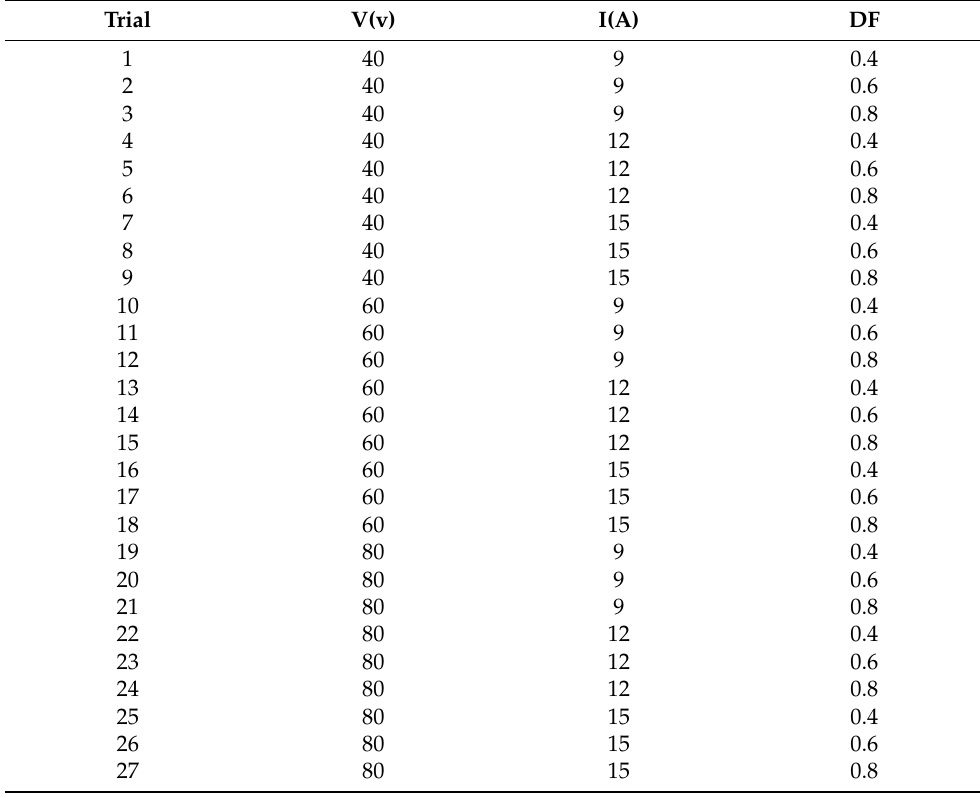
Table 2. Process parameters and the variables of the present